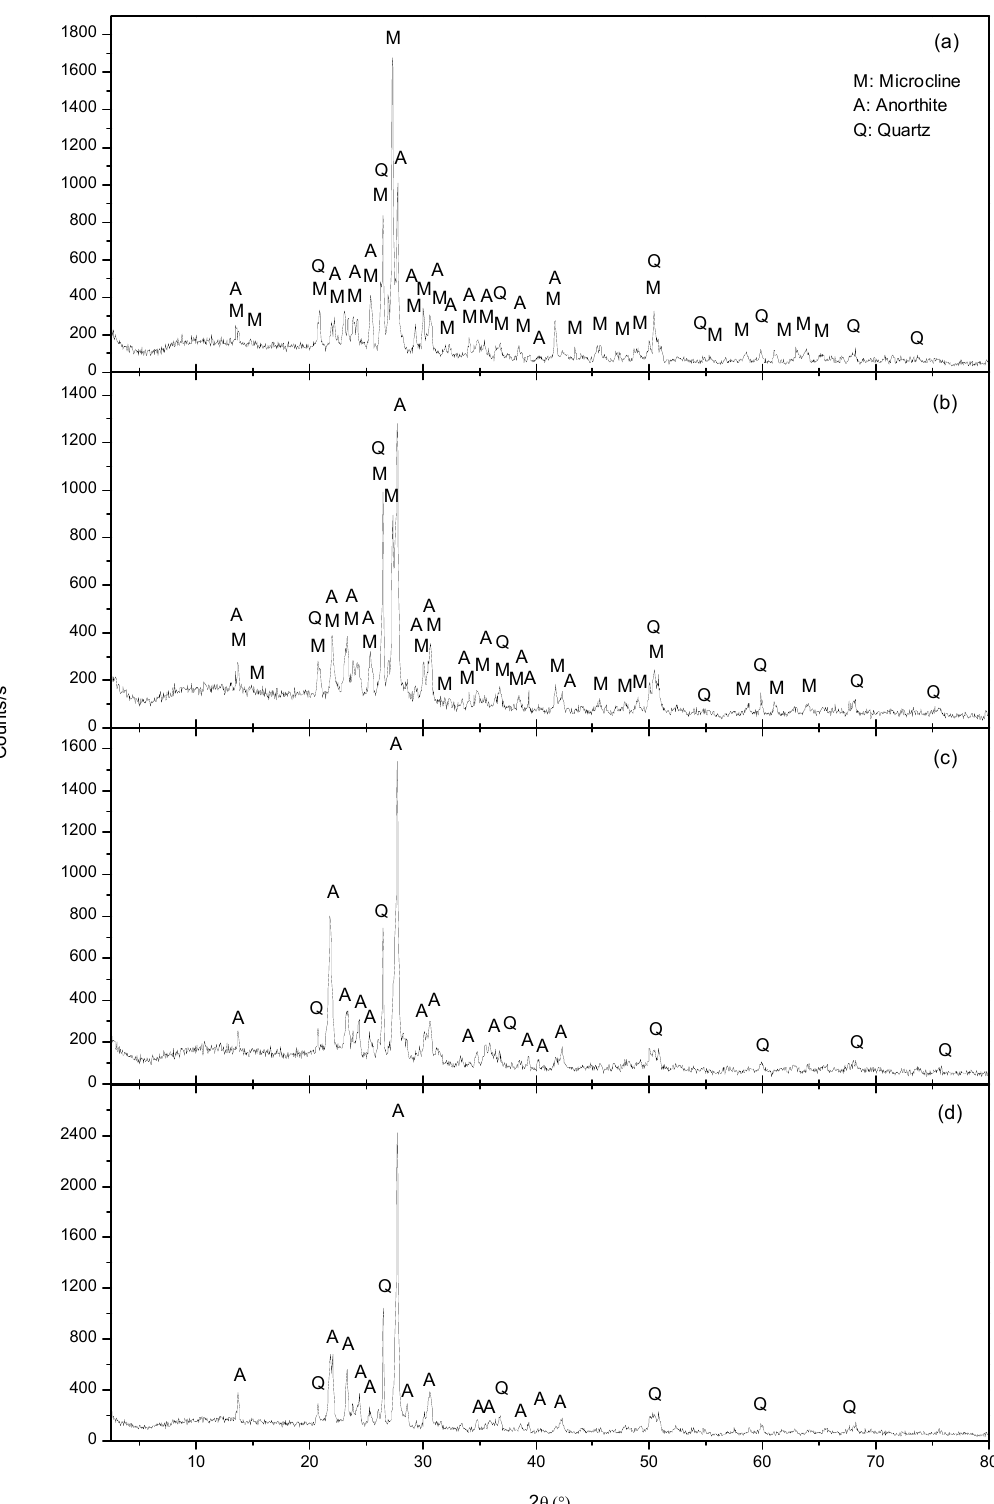
Figure 8. XRD patterns of Mi sample calcined in Cl 2 (g): ( a ) 700 °C for 15 min, ( b ) 800 °C for 60 min, ( c ) 900 °C for 60 min, ( d ) 900 °C for 120 min.